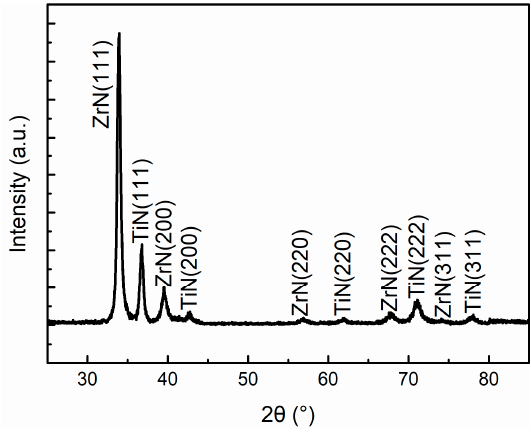
Figure 4. XRD diffractogram of TiN /ZrN coatings.